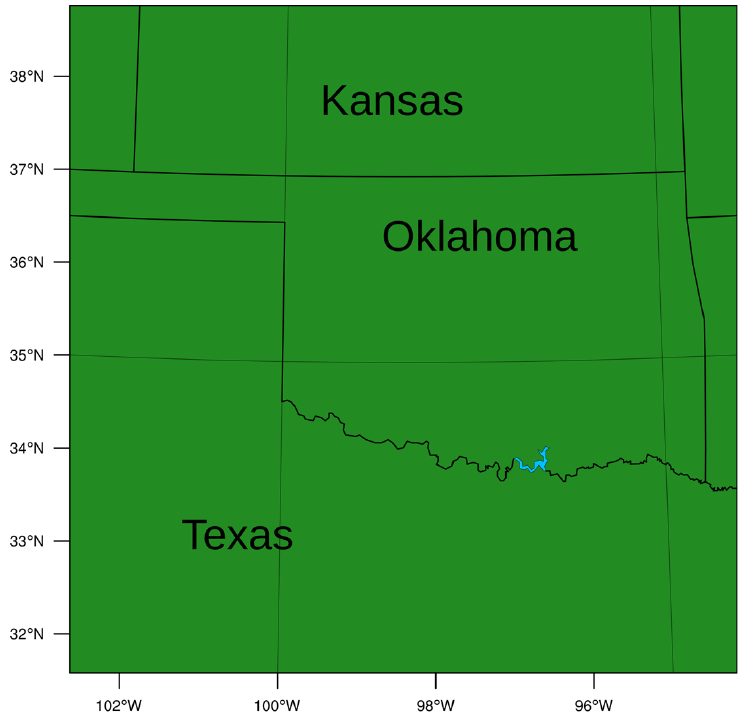
Figure 1. Areal extent of the Advanced Research version of the Weather Research and Forecasting model (WRF-ARW) 1 km domain. Adapted from Reen et al. [20].